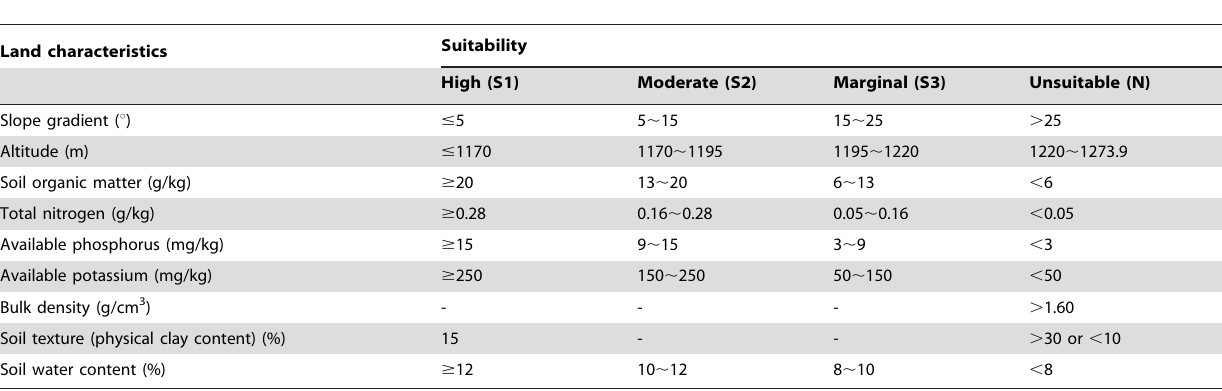
Table 5. Land characteristics, thresholds and degree of suitability for arable